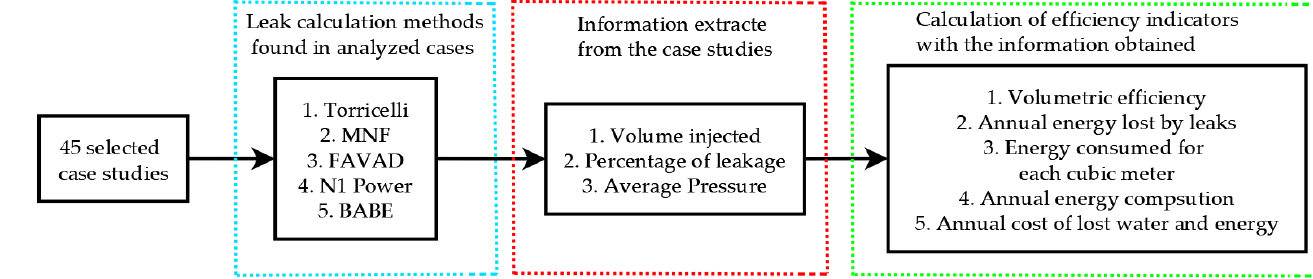
Figure 1. Analysis and calculations made to case studies.